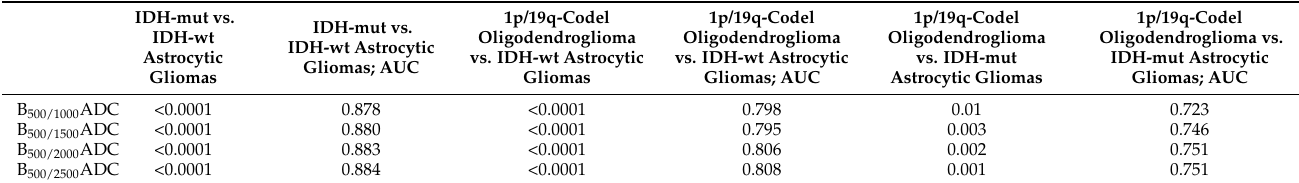
their high b-values such as 2500 s/mm 2 (see Table 4). Table 4. Statistical differences ( p -values) and AUC from ROC analysis of the three glioma subgroups for B 0 ADC evaluation: AUC, area under the curve; ROC, receiver operation characteristic; MK, mean kurtosis; MD, mean